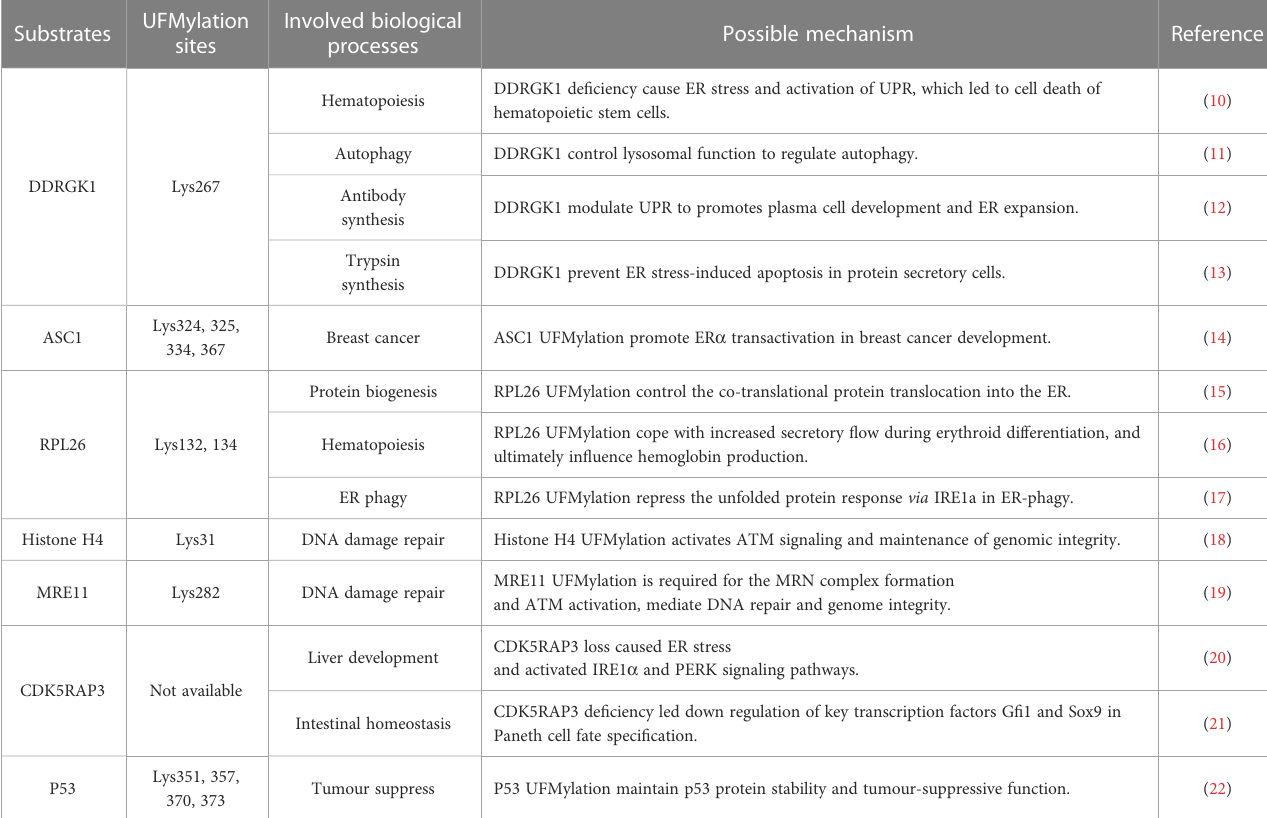
TABLE 1 The role of UFMylation in pathology and physiology.